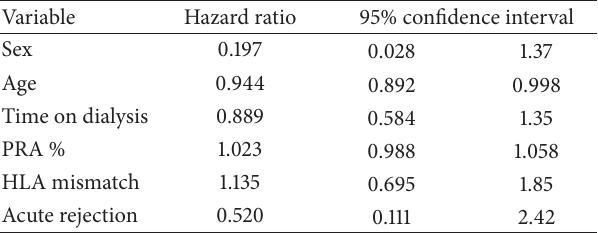
Figure 2: Graft failure due to disease recurrence over time. Table 1: The performance of various clinical and immunological parameters as predictors of the development of recurrent membra- nous